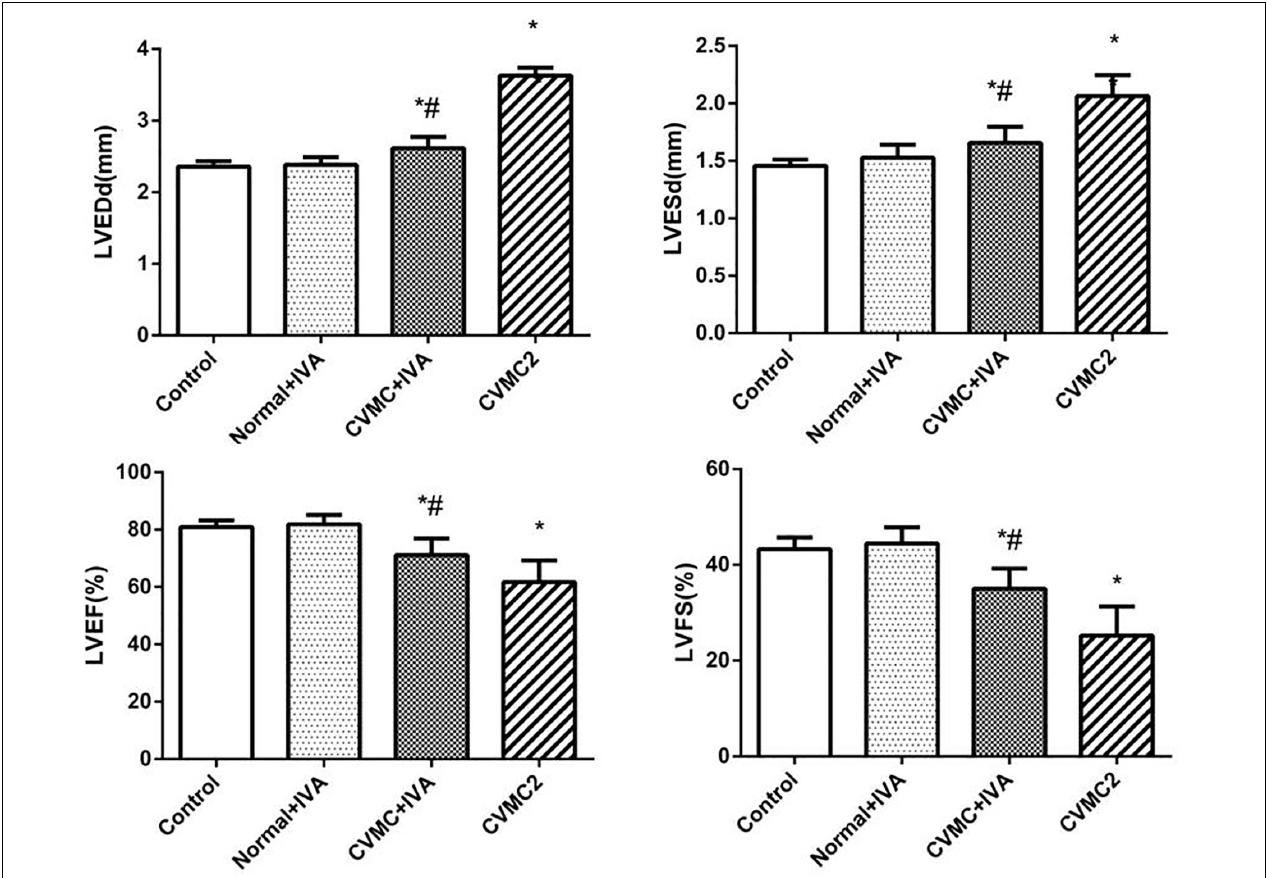
FIGURE 3 | The echocardiography results in Normal control 2 group ( n = 8), Normal + IVA group ( n = 8), CVMC + IVA group ( n = 8), and CVMC2 group ( n = 8) on the 72nd day. Treatment with ivabradine (IVA) significantly reduced the left ventricular internal diameter and apparently increased the LVEF and LVFS in CVMC+IVA group as compared to that in CVMC2 group. LVEDd = left ventricular end diastolic dimension, LVESd = left ventricular end systolic dimension, LVEF = left ventricular ejection fraction, LVFS = left ventricular shortening fraction. ∗ P < 0.05 vs. Control (Normal control 2 group), # P < 0.05 vs. CVMC2.